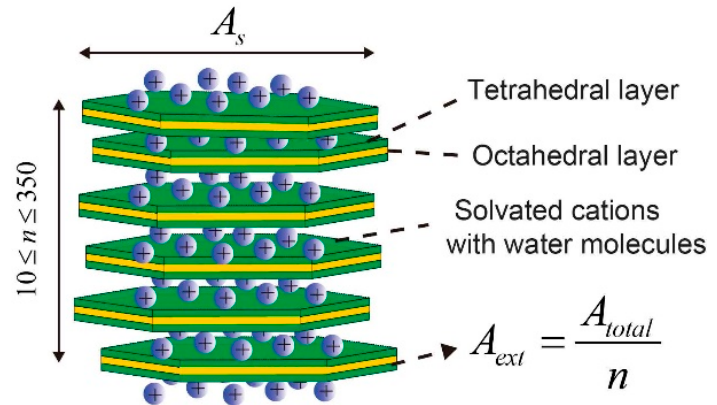
Figure 1. A schematic diagram of lamellar structures of sodium bentonite. To estimate the evolution of pore structure, the surface area ( A s ) of a single TOT layer in particles ( A s ) needs to be assessed. The external specific surface area is defined as the external surface of a particle divided by the mass of the particle,